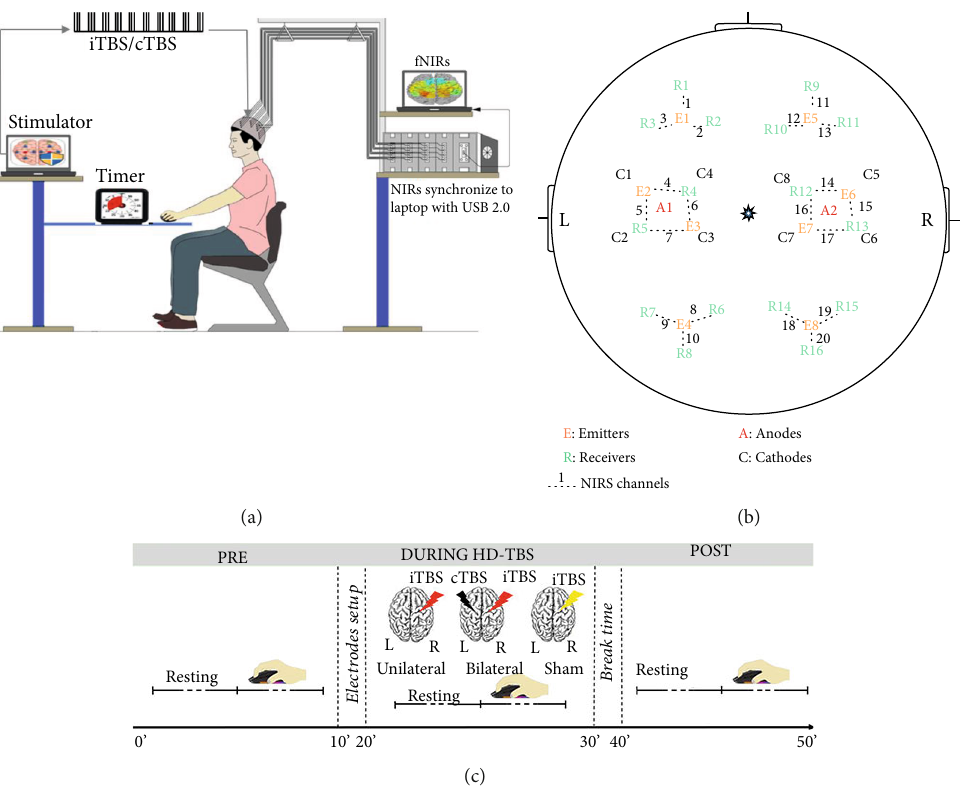
Figure 1: Schematic illustration for experimental design. (a) The experimental setup: subjects sit comfortably on an adjustable chair and worn a 10-20 system electroencephalography (EEG) head cap attached with HD-TBS electrodes and NIRS emitters and receivers; (b) NIRS montage covering bilateral PFC, SMC, and PL and HD-TBS electrodes arrangement; and (c) three phases (pre, during, and post) of each HD-TBS session with resting-state and fi nger-tapping exercises in each phase.